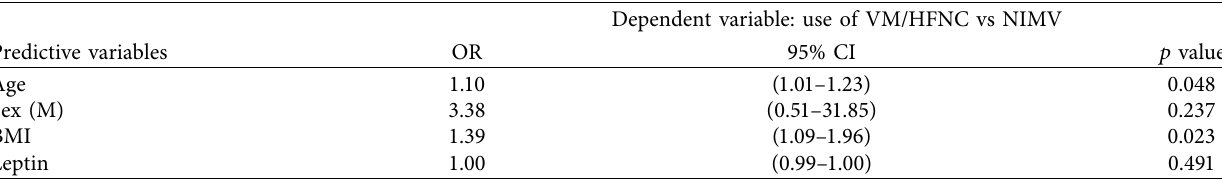
Table 4: Logistic multivariate regression models evaluating the association of BMI and leptin with maximum respiratory support. Dependent variable: use of VM/HFNC vs NIMV Predictive